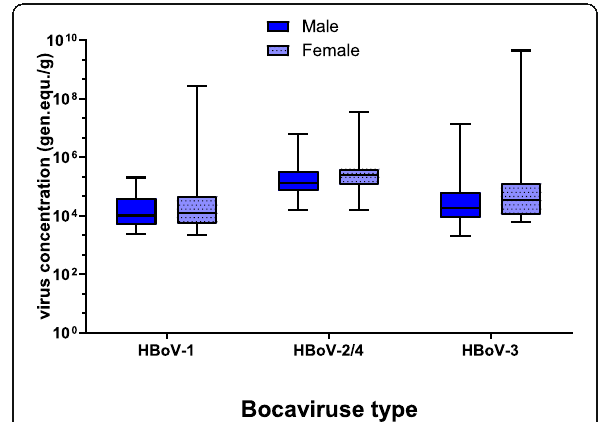
Fig. 1 Concentration of bocaviruses in male and female stool samples of under five